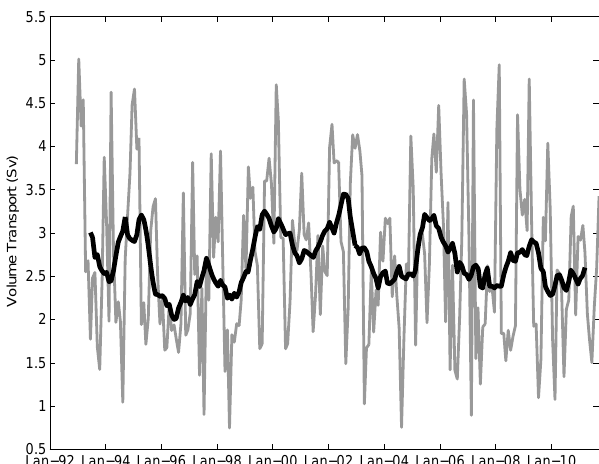
Fig. 10. Temporal variation of the Atlantic inflow through the FSC between the shelf edge on the Faroe side and 150m depth on the Shetland side since December 1992, based on altimetry data cal- ibrated by ADCP and CTD data. Thin grey line shows monthly mean, thick black line 12month running